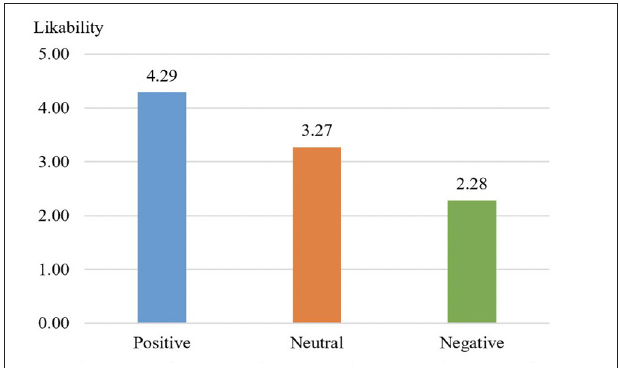
FIGURE 2 | Mean differences between self-disclosure valances in